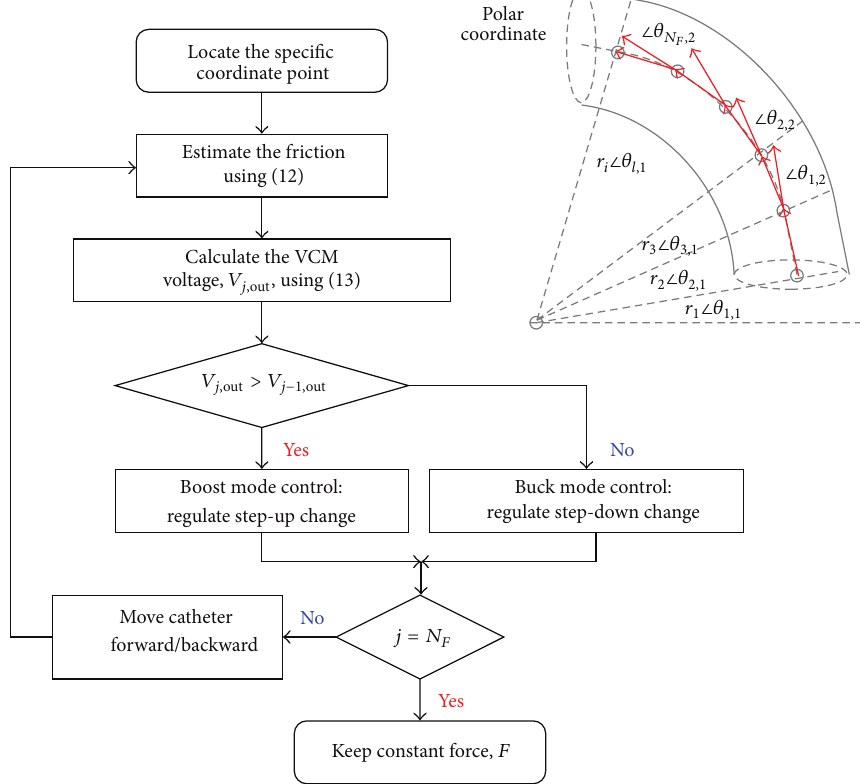
Figure 7: The flowchart of haptic force